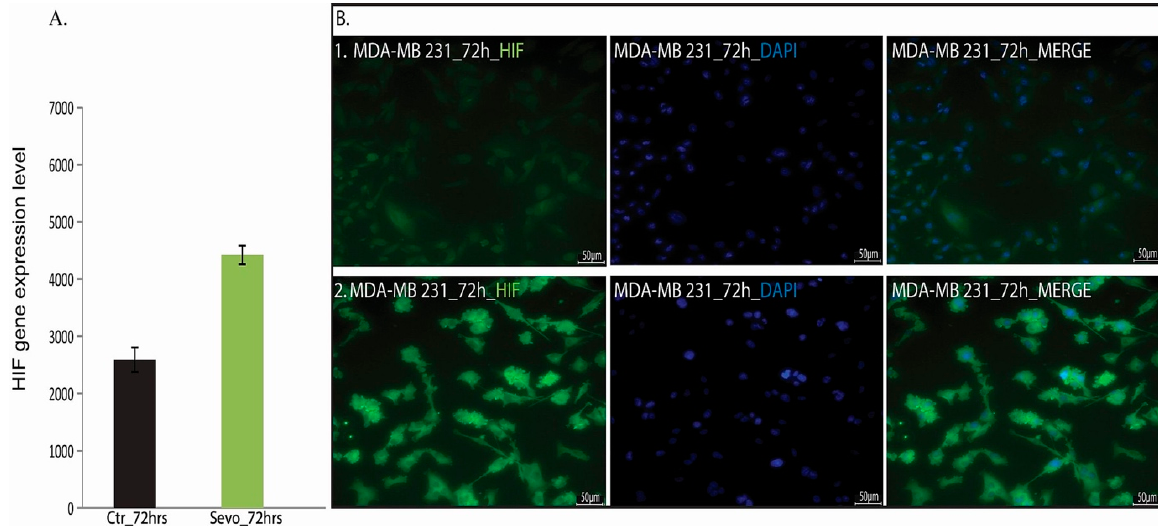
Figure 7. HIF-1 α expression. ( A ) HIF-1 α gene expression level; ( B ) HIF-1 α protein expression level; (1. 6 h post-sevoflurane exposure; 2. 72 h post-sevoflurane exposure). n = 1 ( A ), n = 2 ( B ).